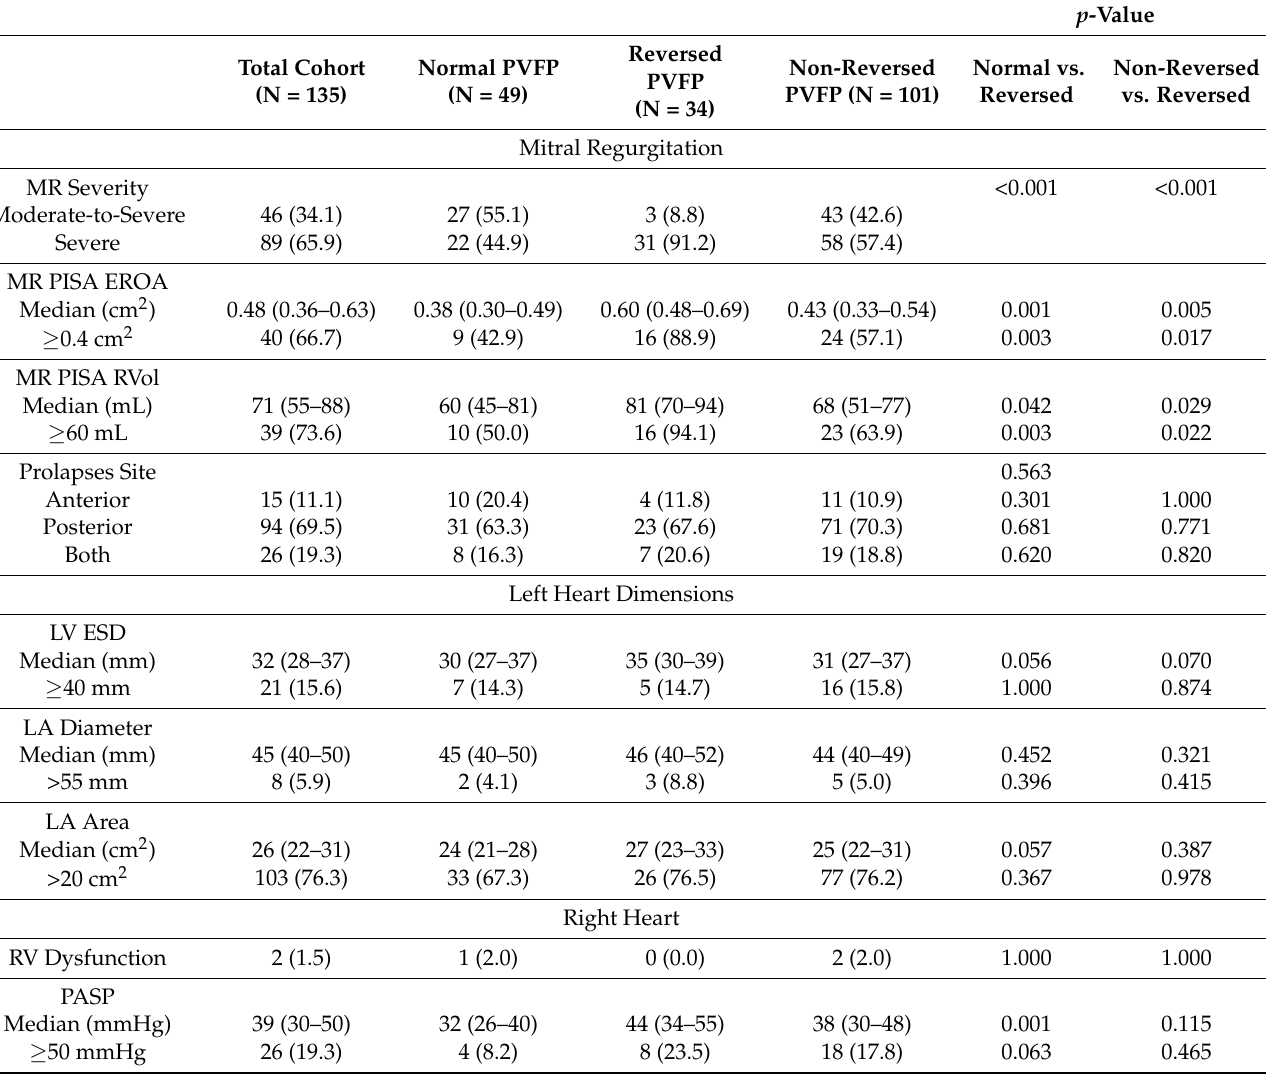
Table 2. Baseline Echocardiographic